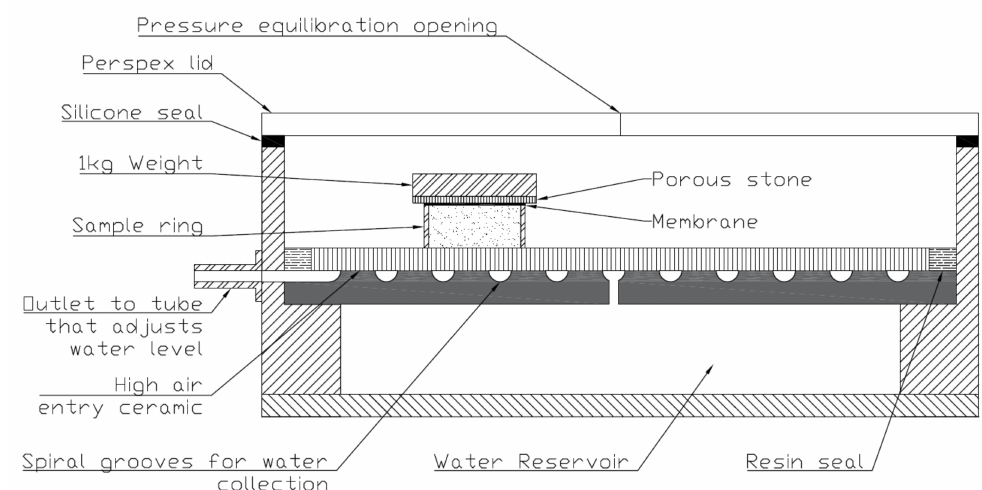
Figure 3. Diagram of the hanging column apparatus and test sample. All tests started with saturated specimens, and suction was incrementally increased, facilitating the determination of the drying path of the WRC. Note that the hanging water column, which attaches to the outlet, is not